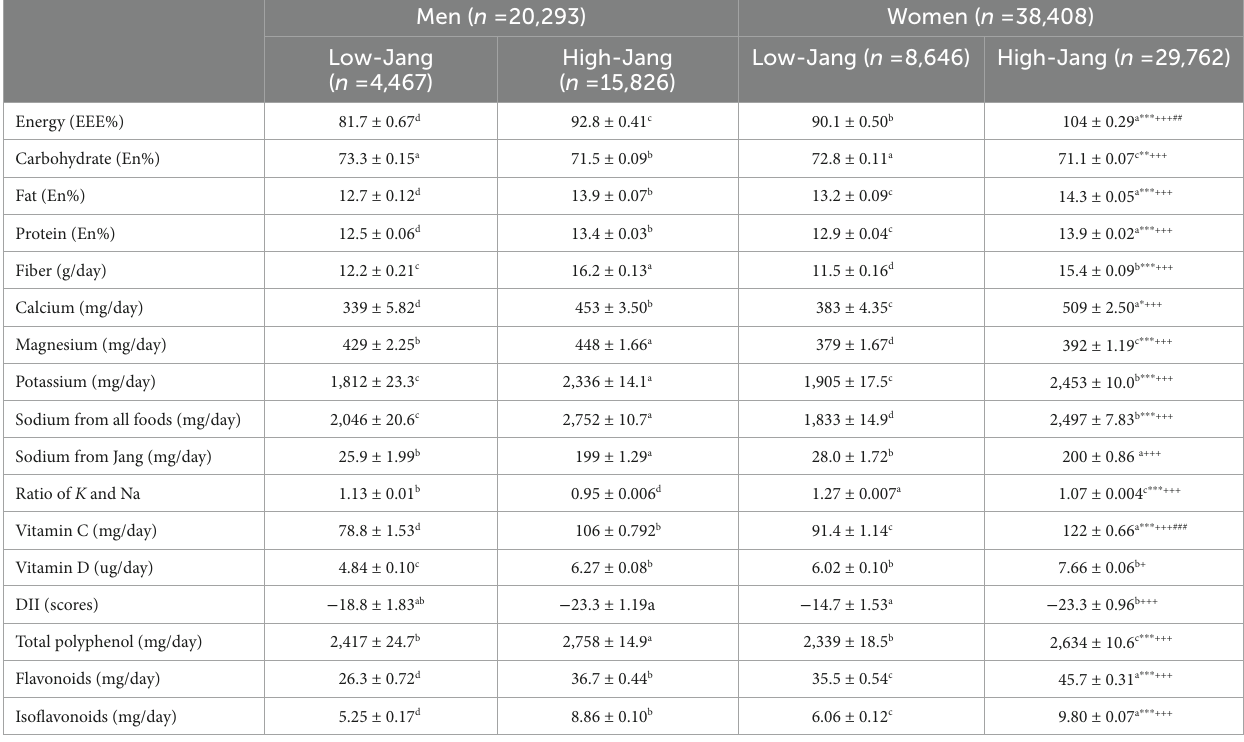
TABLE 3 Nutrient intake according to gender and Jang